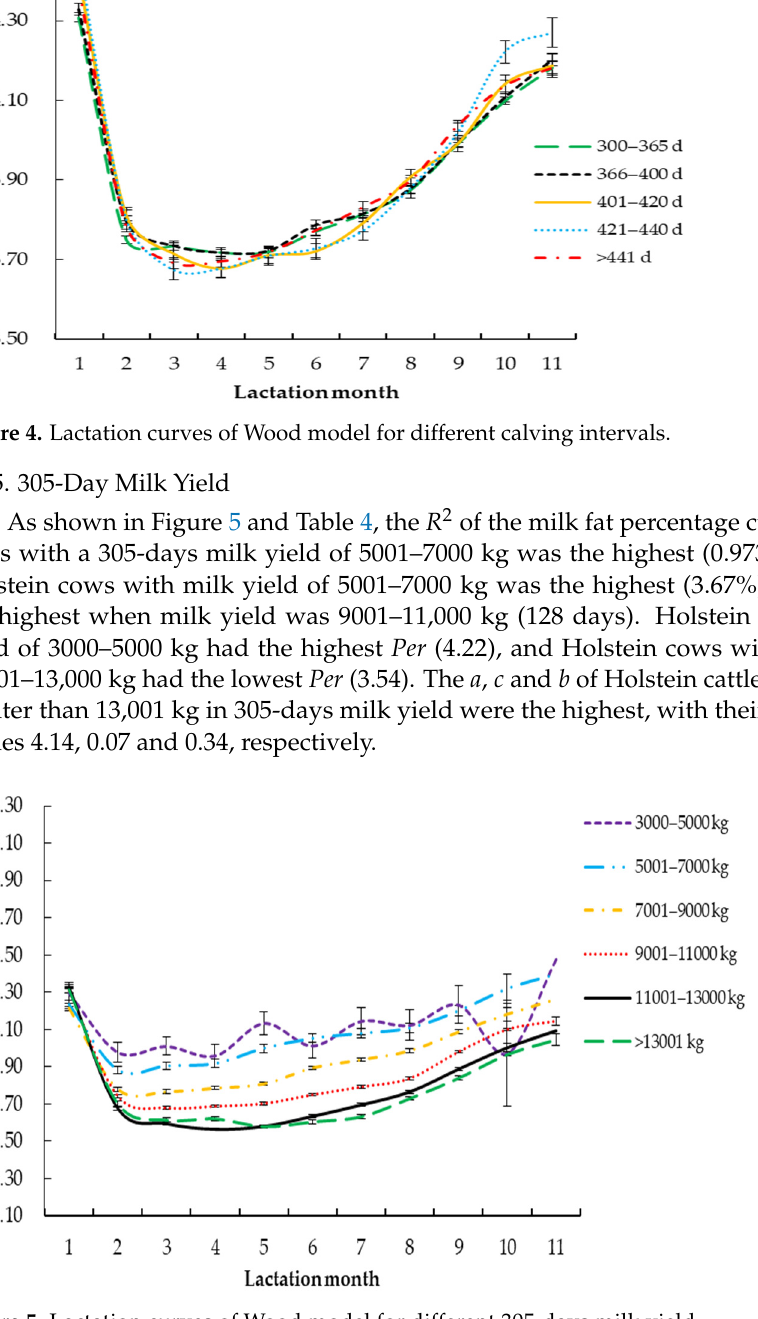
Figure 5. Lactation curves of Wood model for different 305-days milk yield.